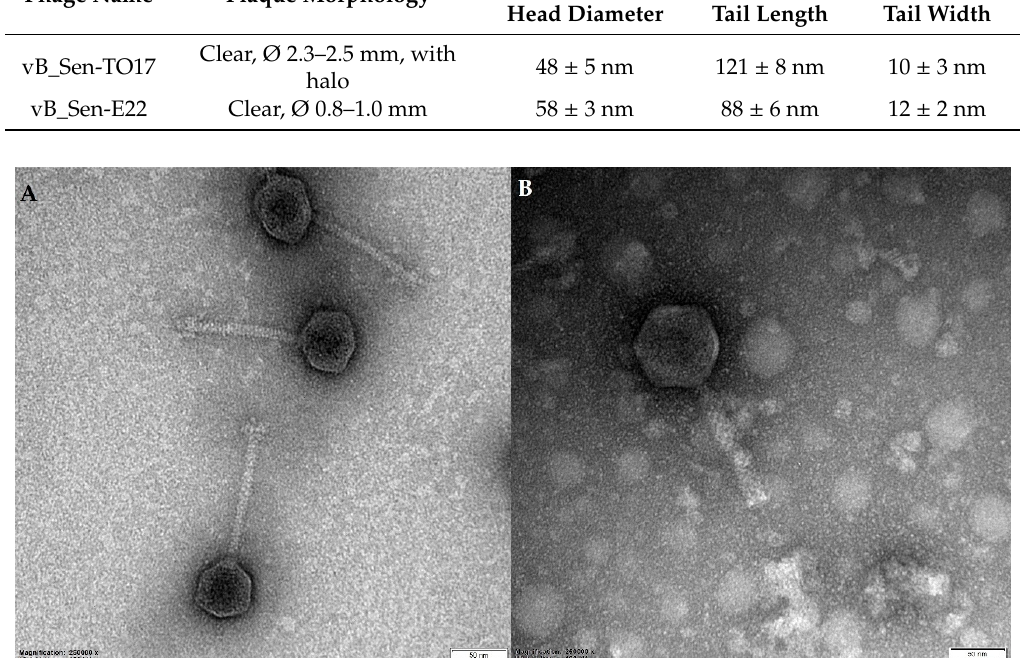
Figure 2. Electron micrographs of virions of vB_Sen-TO17 ( A ) and vB_Sen-E22 ( B ). Size bars (representing 50 nm) are shown at the bottom of each micrograph.